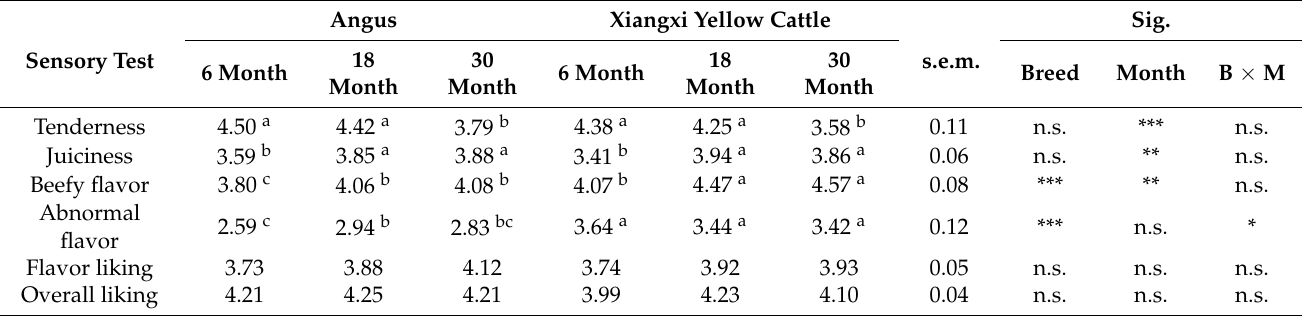
Table 5. Sensory evaluation of LT muscle from Angus and Xiangxi yellow